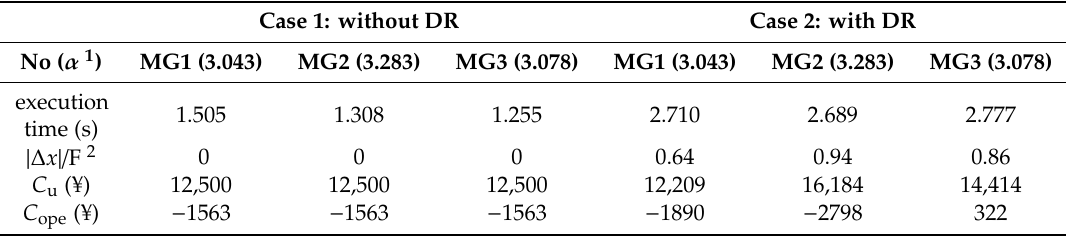
Table 3. Costs of MGs and execution time with / without DR.